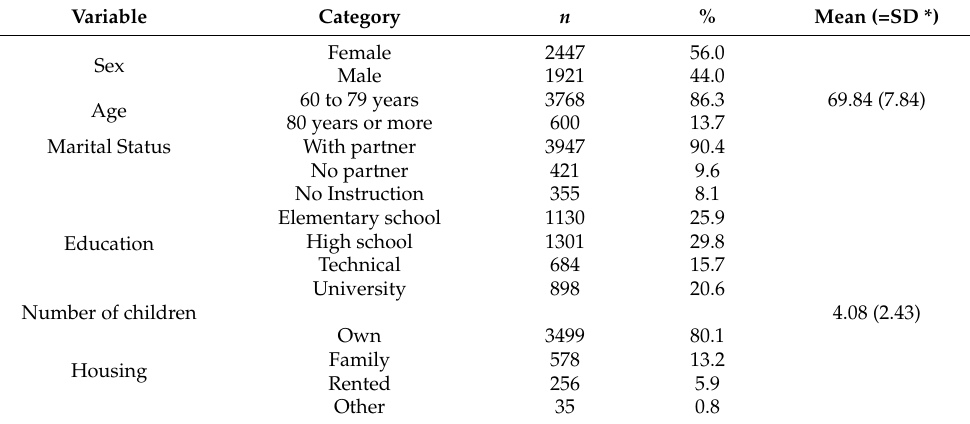
Table 1. Sociodemographic characteristics of older adults during the COVID-19 pandemic. Peru, 2021.